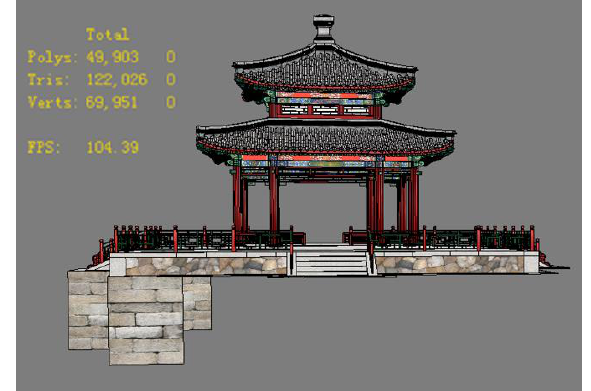
Figure 2. Previous 3D Model of Liuxiangzhu Pavilion